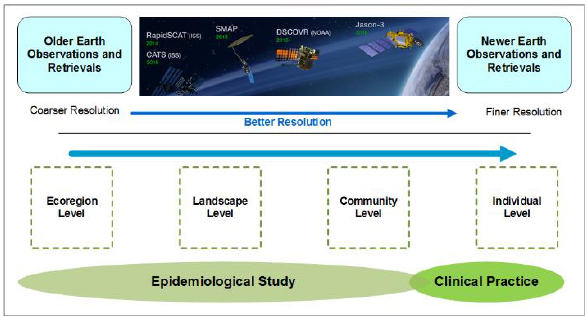
Figure 1. Generalized scenario of the advancement of Earth observations and geospatial technology generating environmental data suitable for clinical